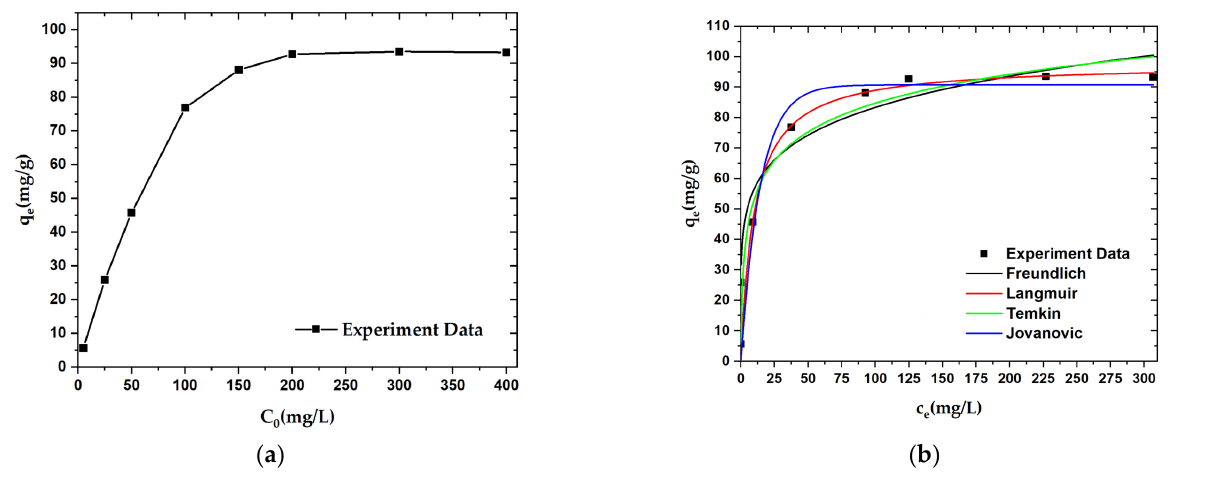
Figure 9. The removal efficiency of the material with paraquat.